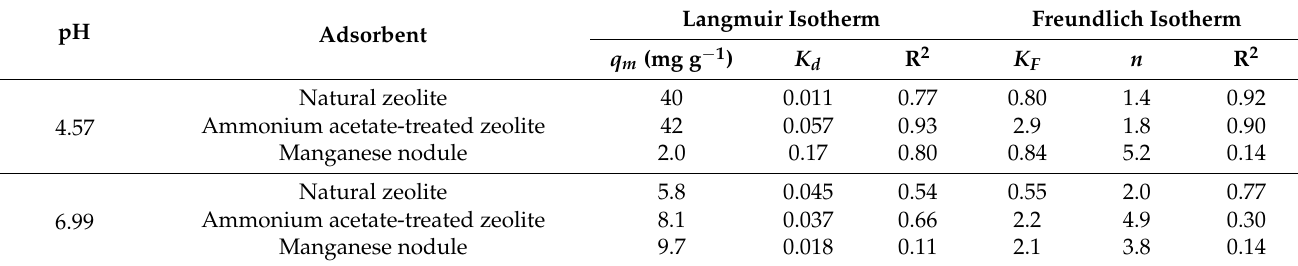
Table 1. Langmuir and Freundlich isotherm parameters for potassium sorption at pH 4.57 and 6.99.